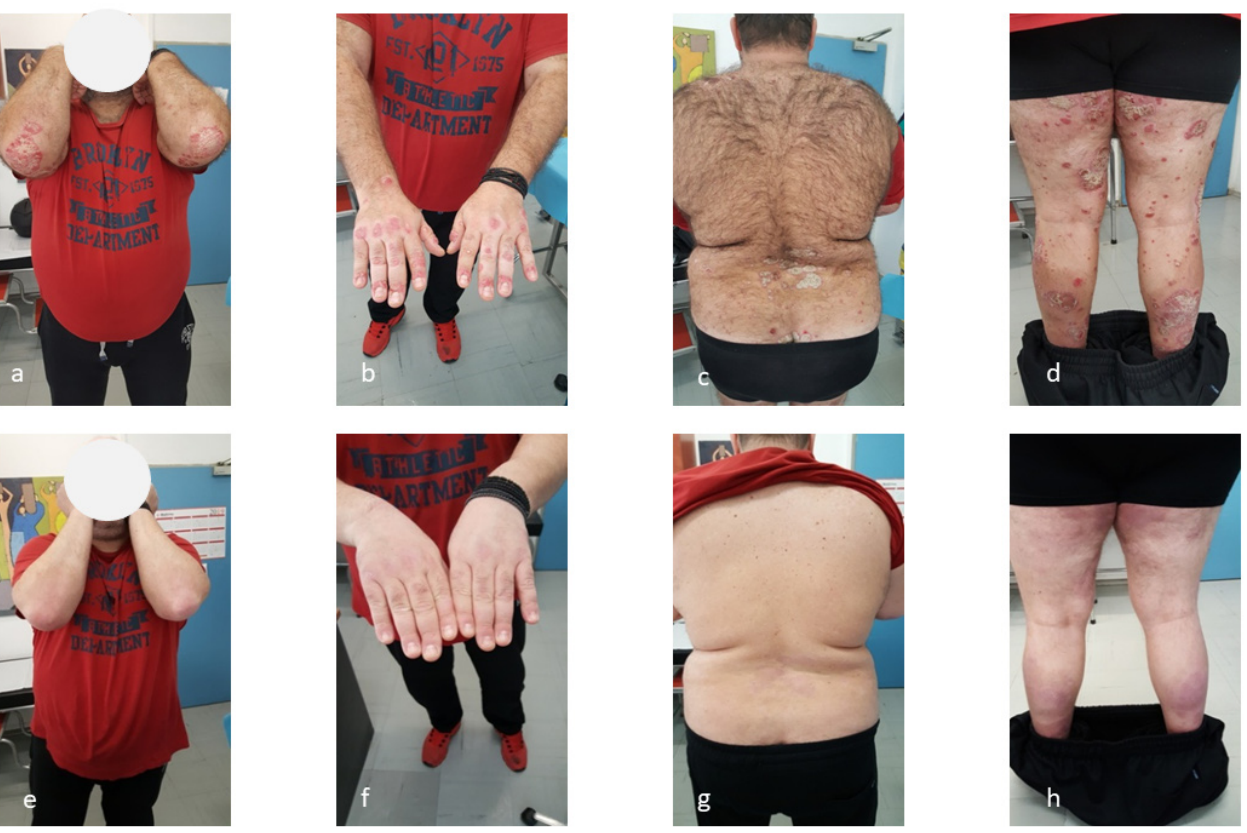
Figure 2. Psoriatic lesions of patient 2. ( a – d ) Psoriatic lesions of second patient before treatment with brodalumab. ( e – h ) Psoriatic lesions of second patient after treatment with